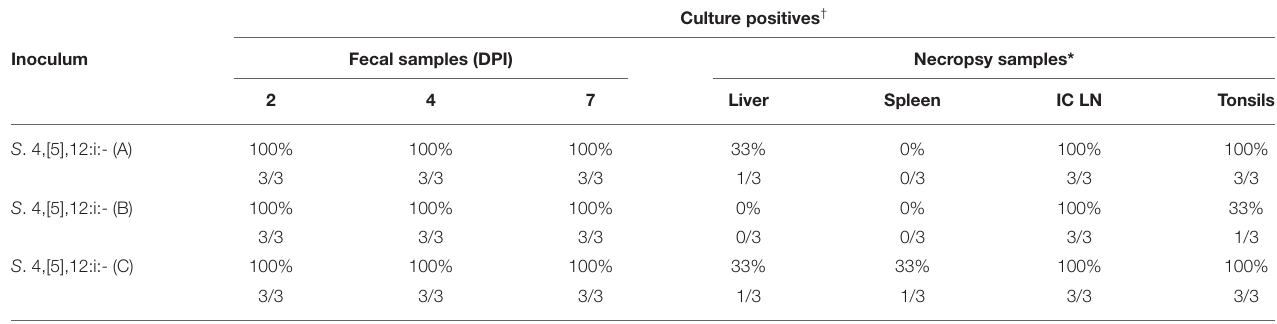
TABLE 2 | Culture results of three separate isolates of Salmonella 4,[5],12:i:- from animal study #1.